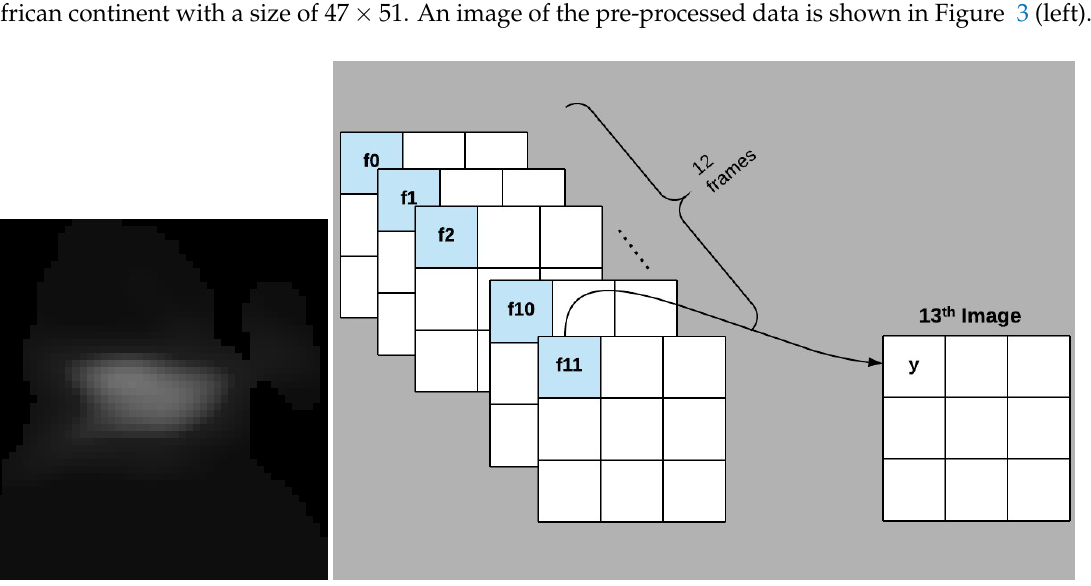
Figure 3. Overview of dataset preparation for feature selection: ( left ) Example of groundwater image of southern Africa before pre-processing (note image is inverted vertically); ( right ) Notation for same-pixel features used in image